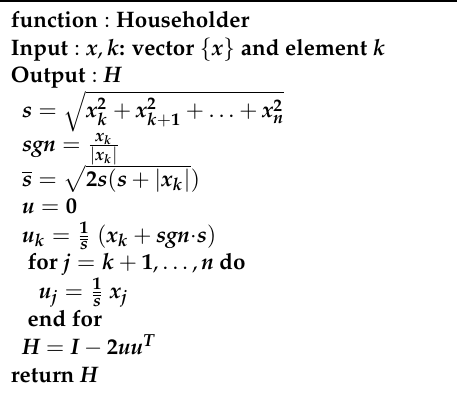
Table 6. The Householder